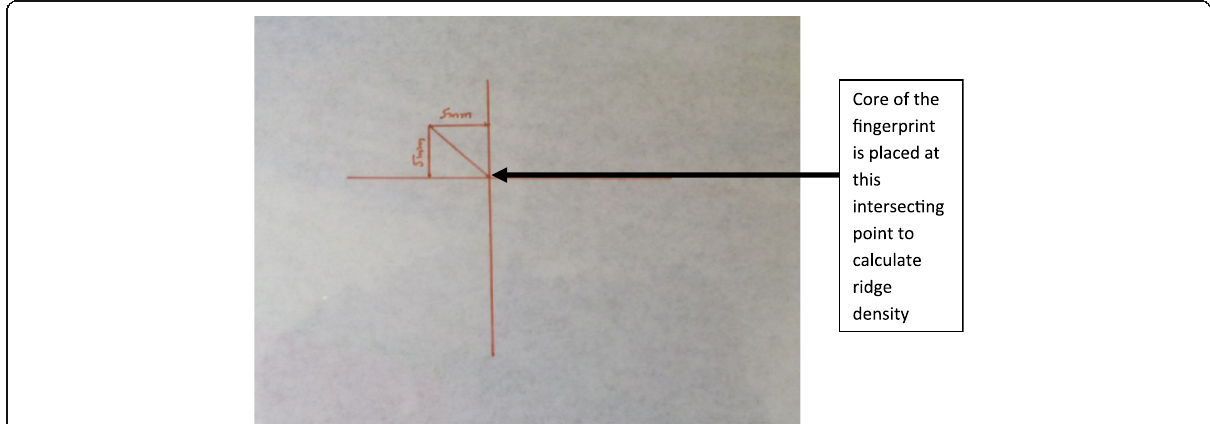
Fig. 1 The sample scanned image of scale used to conclude ridge densities as per Acree ’ s method (1999). A square was drawn (5mmX5mm) with total Square area constituting 25mm